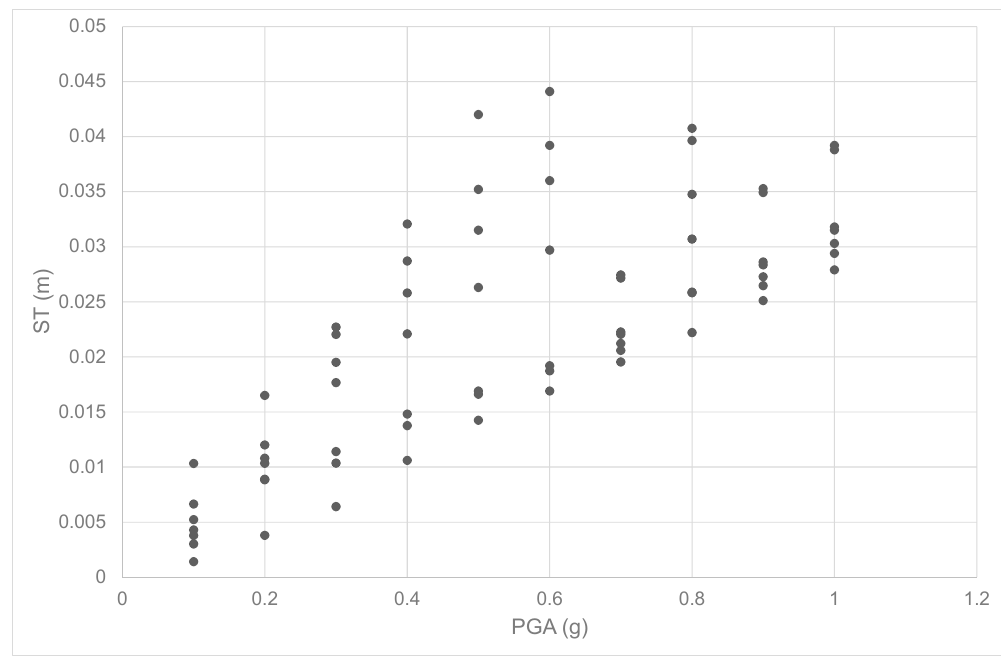
Figure 11. SSI: relationships between PGA (g) and LS (m).